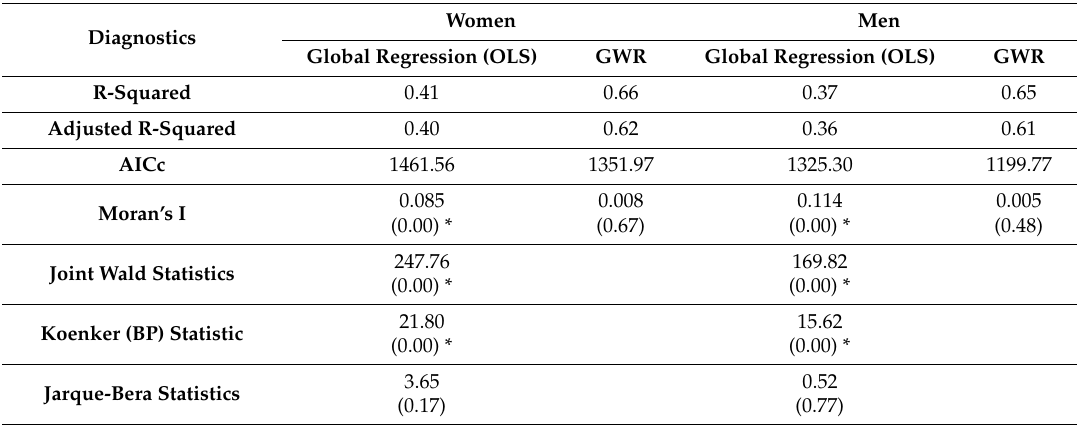
Table 3. Ordinary least squares (OLS) and geographically weighted regression (GWR) diagnostics.